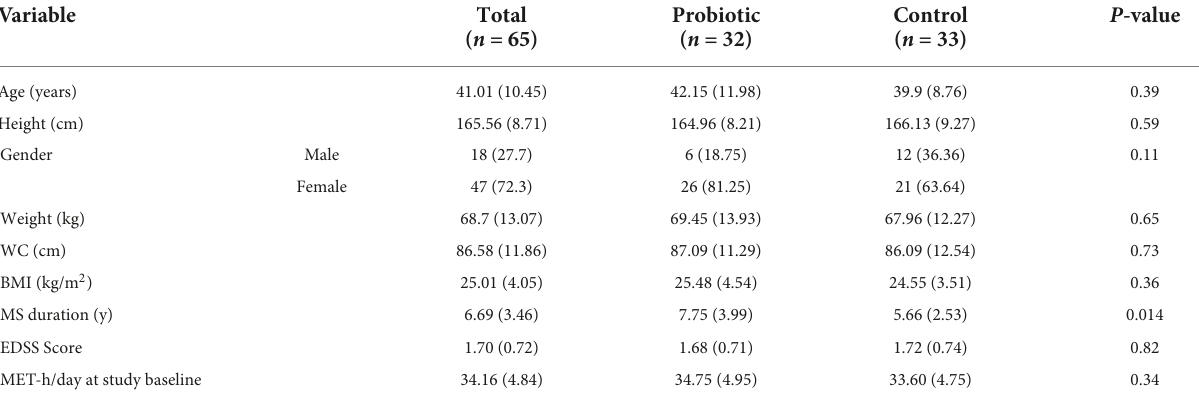
TABLE 1 Baseline characteristics of the